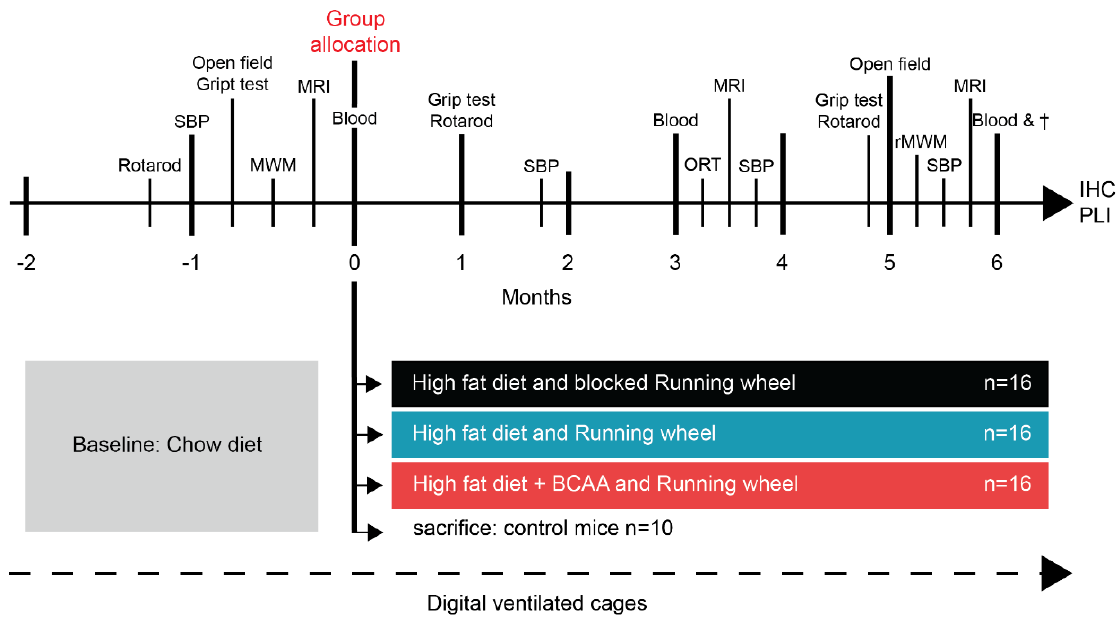
Figure 1. Study design. At 2 months of age (t = − 2), 58 male Ldlr − / − .mice were selected for the present study and housed in pairs in digital ventilated cages. All mice were maintained on a standard chow diet during 8 weeks of baseline measurements. Baseline measurements included several experimental procedures, including systolic blood pressure (SBP) measurements, open field test, grip strength test, Morris water maze (MWM), and magnetic resonance imaging (MRI). Mouse pairs (sharing one home cage) were equally matched on the basis of body weight, fasting blood glucose, and plasma triglyceride and cholesterol levels (t = 0). (1) Group 1 ( n = 16): a high-fat diet (HFD)-fed group that did not exercise and had a blocked running wheel in the cage. (2) Group 2 ( n = 16): an exercising HFD-fed group (HFD + exercise) that had 24/7 access to a functional running wheel. (3) Group 3 ( n = 16): an exercising HFD-fed group that received additional branched-chain amino acid (BCAA) supplementation and unlimited access to a functional running wheel. At 4 months of age (t = 0), another group of mice ( n = 10) was sacrificed immediately after baseline measurements and